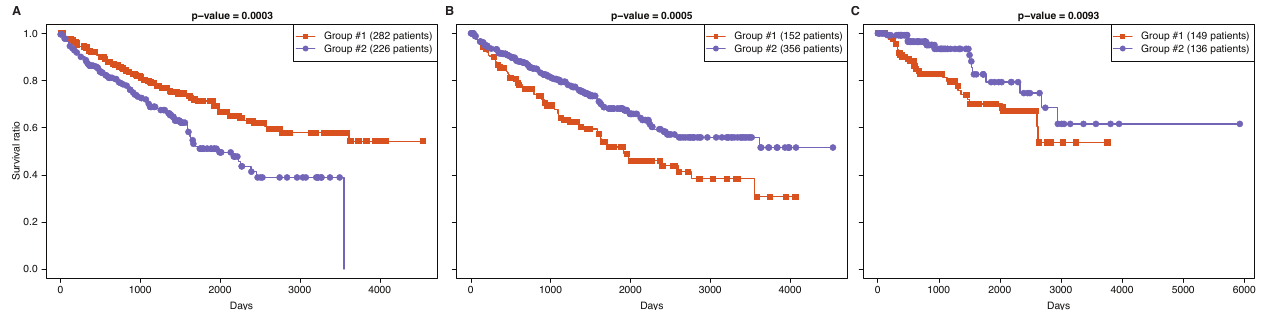
Figure 3. Kaplan-Meier survival curves of two patient groups identified using k -means clustering algorithm for ( A ) cohort-specific regulatory module identified in KIRC cohort, and tissue-specific regulatory module identified for kidney using the same subgroup of selected mRNAs in ( B ) KIRC and ( C ) KIRP patients.